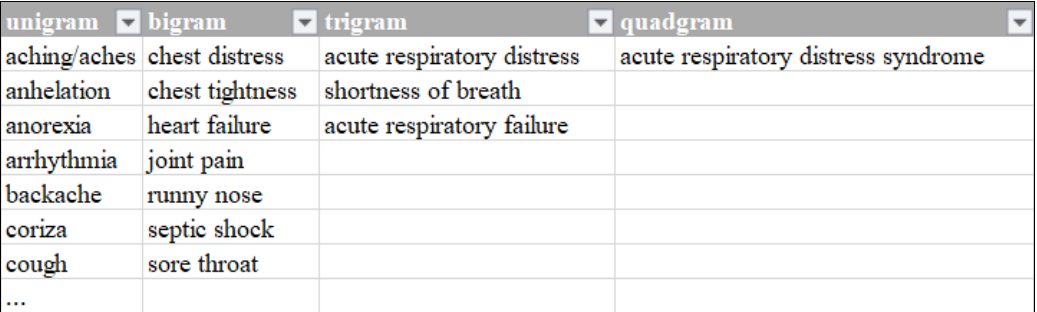
Figure 13. Examples of N-Gram